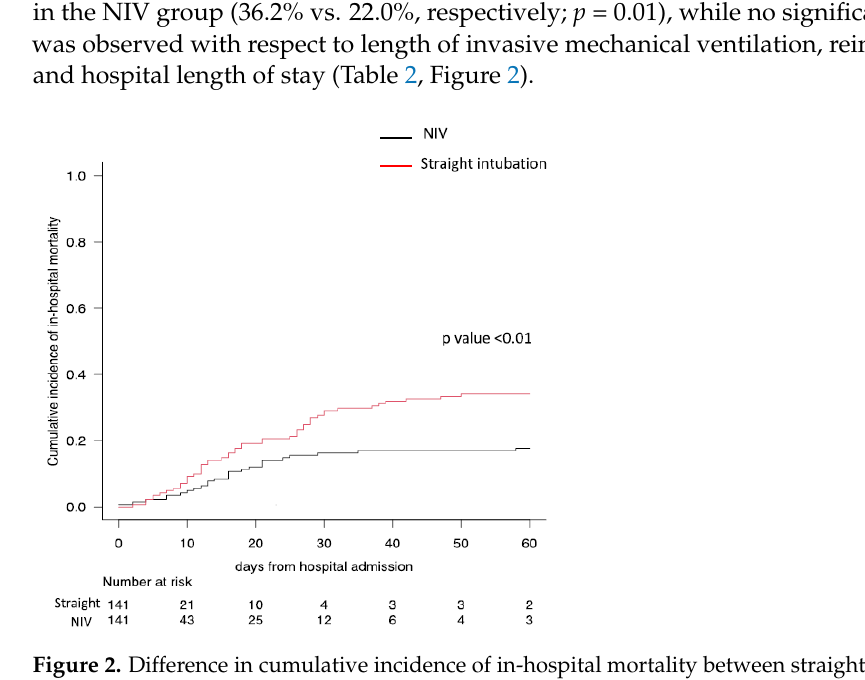
Figure 2. Difference in cumulative incidence of in-hospital mortality between straight intubation and NIV